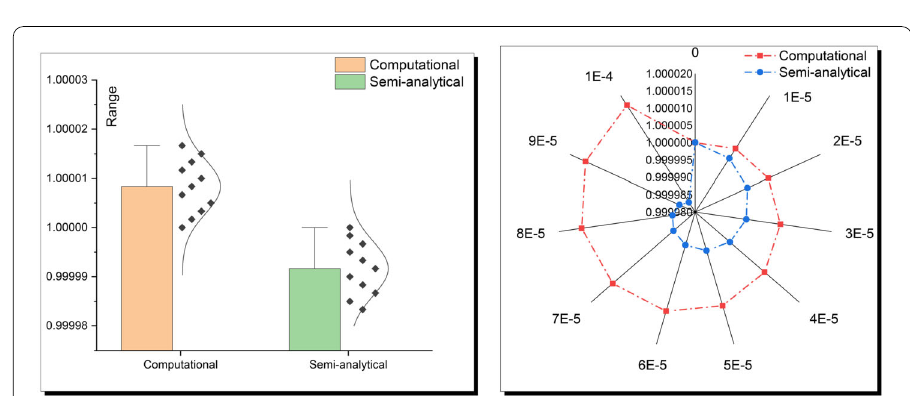
Figure 2 Two-dimensional sketches between the analytical and approximate solutions based on the EK method for illustrating the matching between